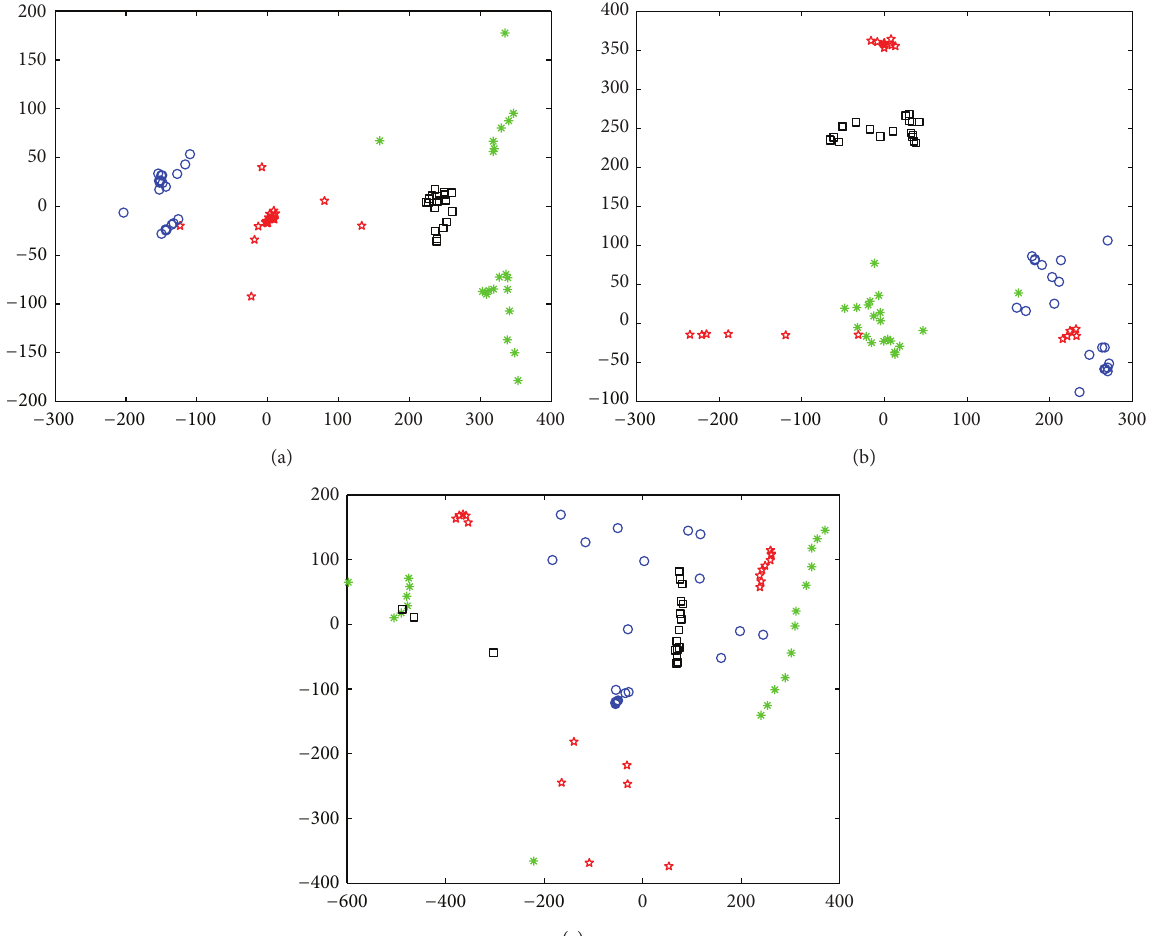
Figure 7: The two-dimensional visualization of the three algorithms. (a) CCIG-LPP, (b) LPP, and (c) PCA.